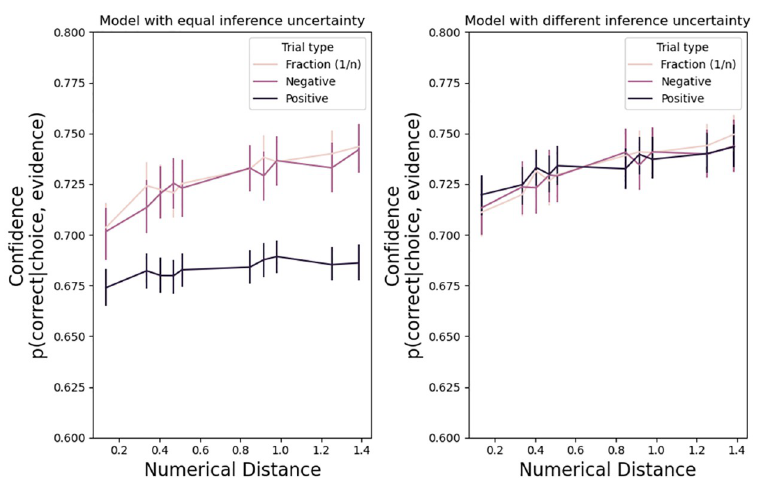
Fig 5. Reduced uncertainty in trials with positive numerals. Exp. 1. models with equal uncertainty had an UN = 2.5 for all types of numerals. Models with different uncertainty had UN pos = 1.65, UN neg = 2.4, UN frac = 2.4. Error bars are